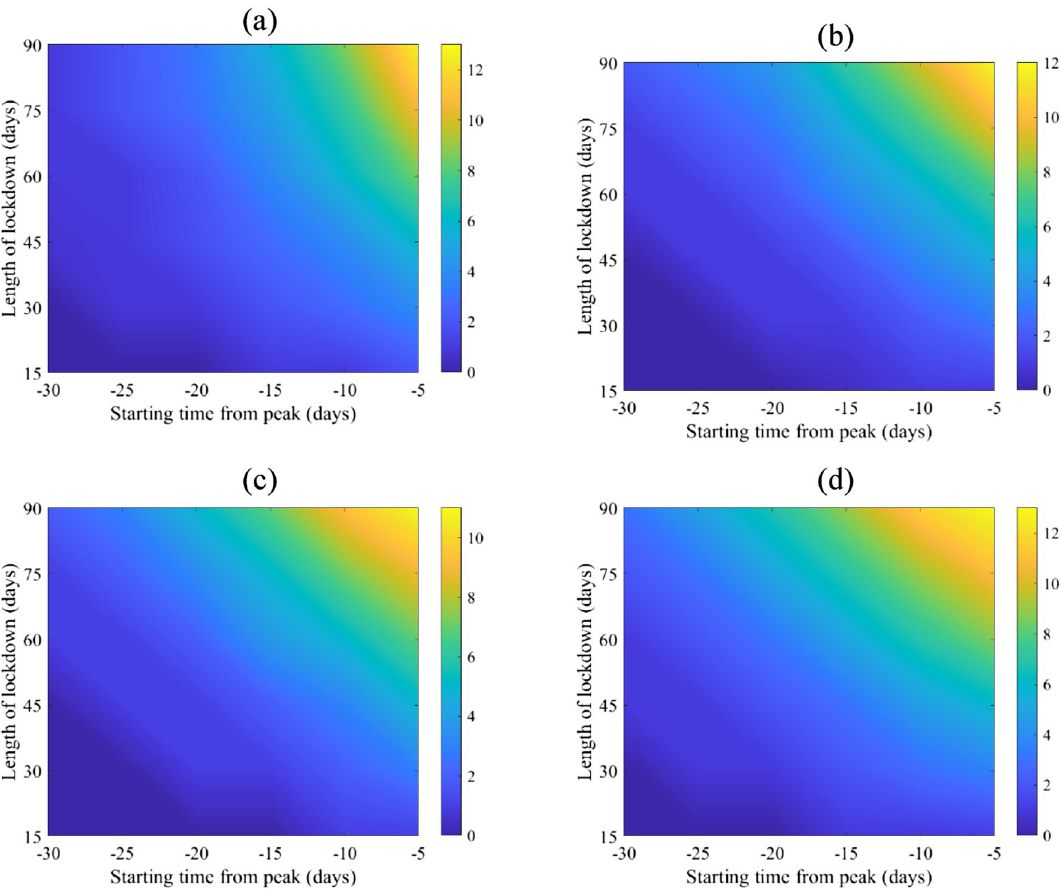
Figure 3. Mean of percentage relative reduction in COVID-19 total attack rates (see Eq. (2)) for ( a ) Canada, ( b ) China, ( c ) Mexico, and ( d ) Niger. They are calculated at R 0 = 6.47 , with initially one adult mild infection. Bars to the right of the figures are